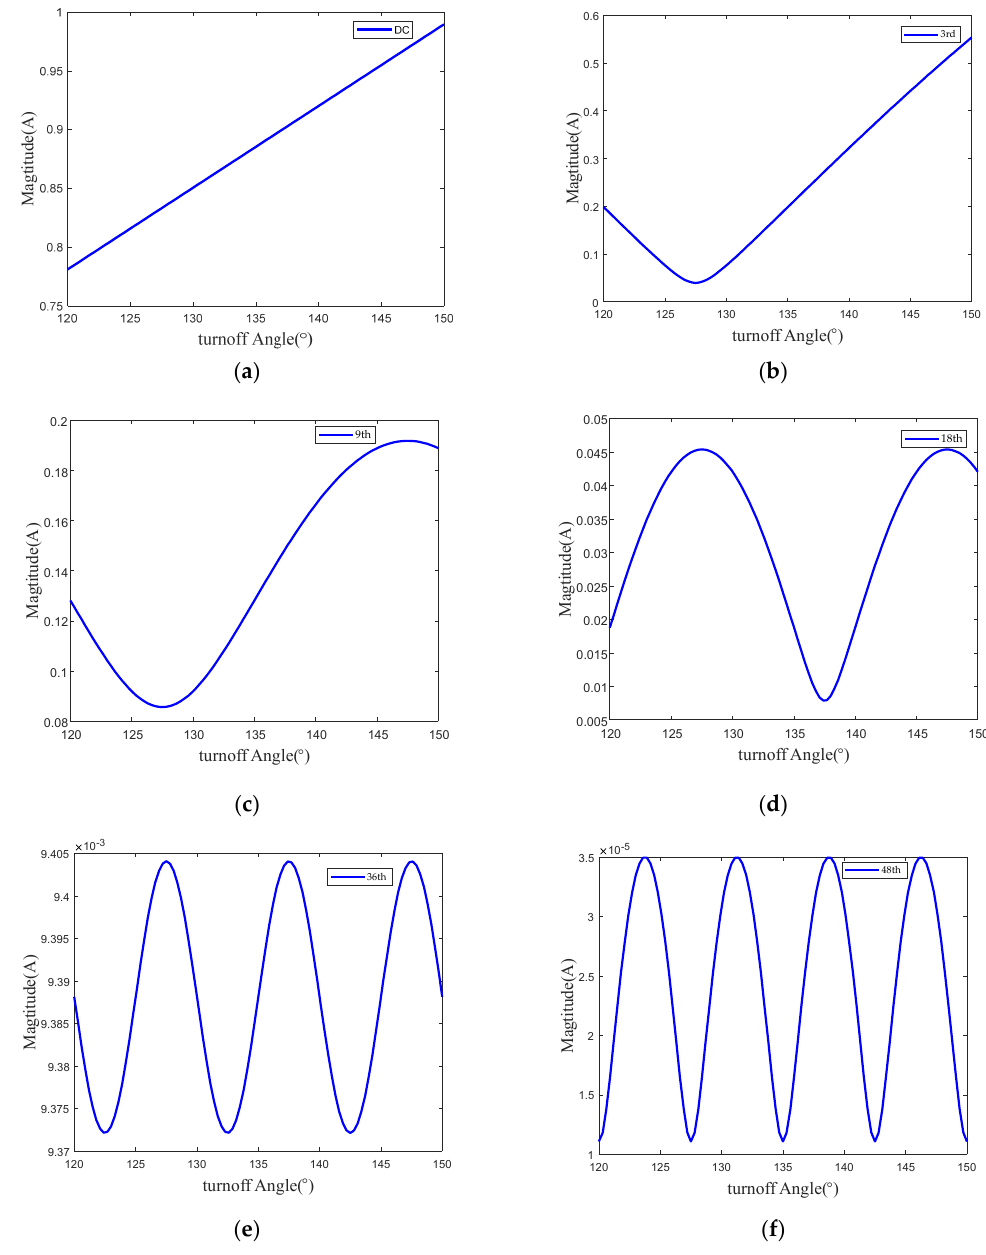
Figure 7. Influence of turn-off angle to current harmonic magnitude ( a ) DC ( b ) 3rd order ( c ) 9th order ( d ) 18th order ( e ) 36th order ( f ) 48th order.